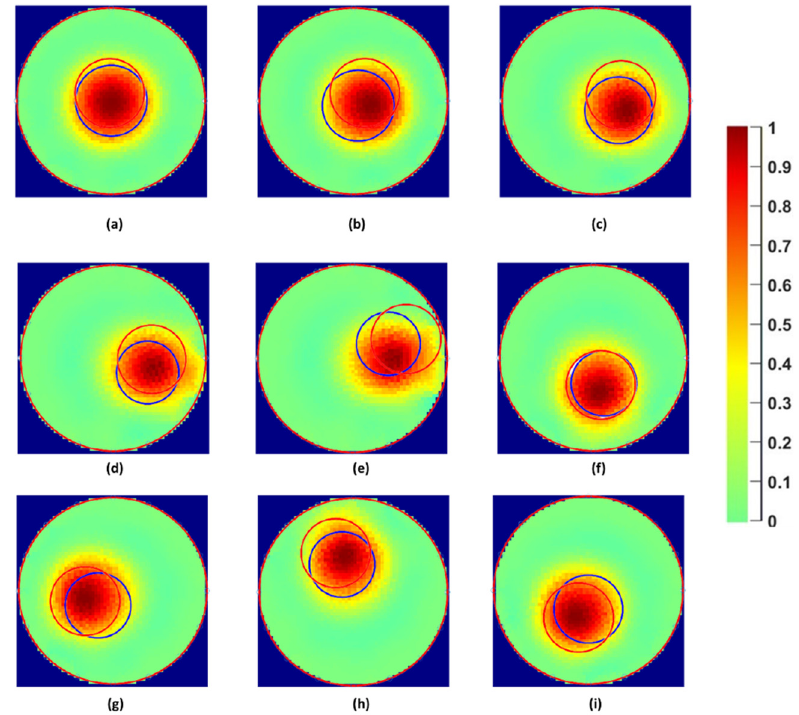
Figure 12. Experimental/real (red) and reconstructed (blue) diameter and position of the phantom superimposed on the traditional tomograms for the point C to P8 ( a – i ) for a 30 mm phantom. The colour bar is shown on the right side of the figure. Table 5. Comparison of three Euclidean distances in the case of the phantom with 30 mm diameter size. L 1 : center distance between the real phantom position and the circle after parametric reconstruction (author’s approach); L 2 : center distance between the real phantom position and the circle after ERT GN image reconstruction (+image processing). L 3 : center distance between circles after parametric reconstruction and image